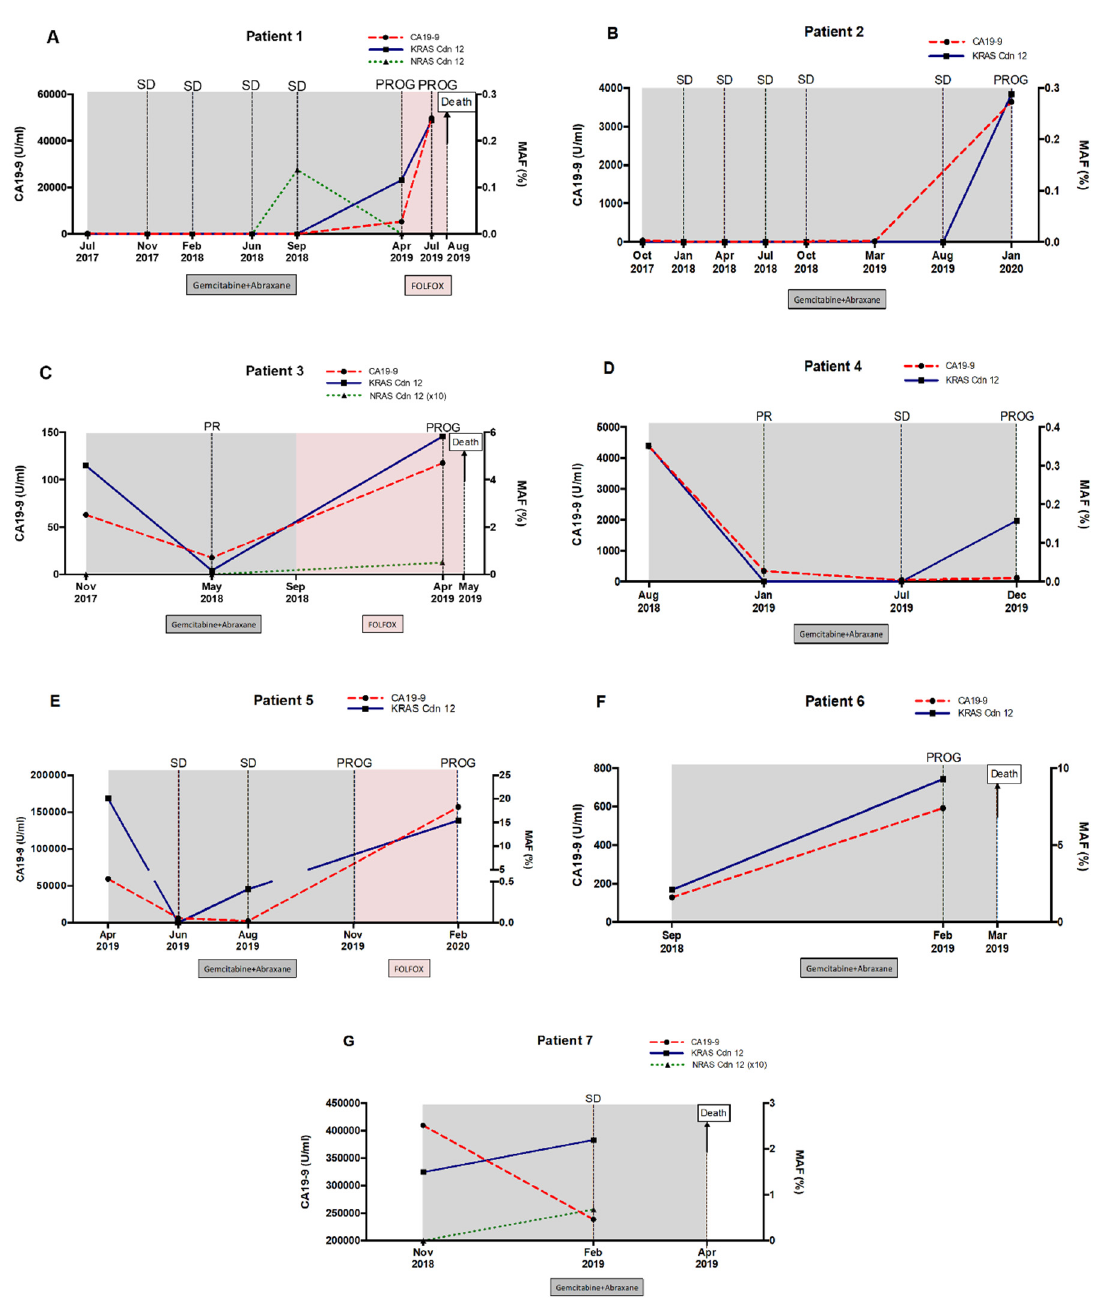
Figure 8. Circulating RAS mutation allele fraction (MAF) enables monitoring of disease progression and response to therapy in metastatic PDAC patients. Circulating MAF (%) was compared to CA19-9 (U / mL), in monitoring response to therapy and disease progression in 8 ( A – G ) metastatic PDAC patients.